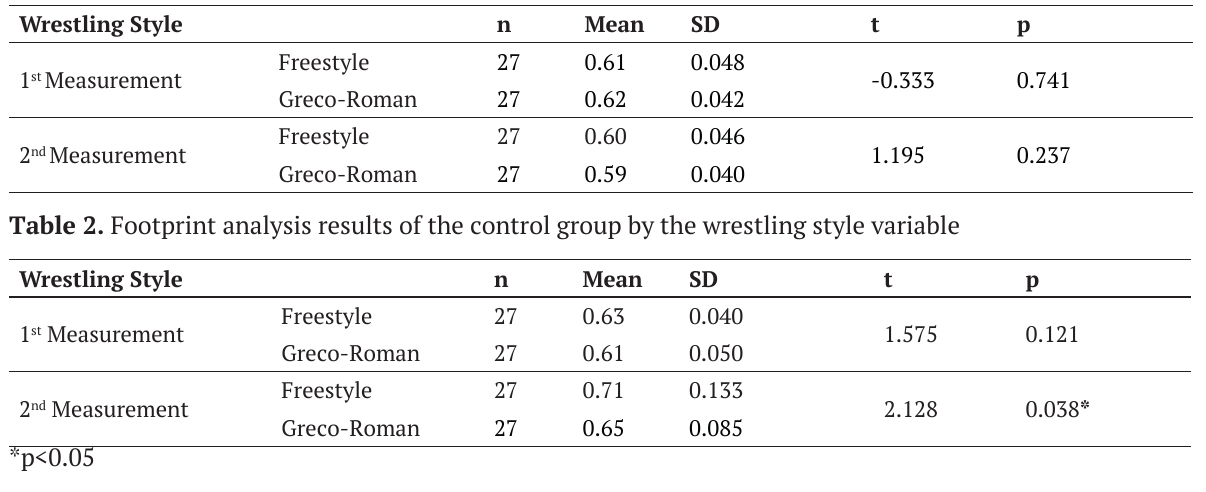
Table 1. Footprint analysis results of the experimental group by the wrestling style variable